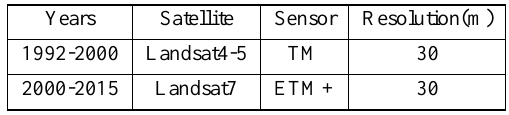
Table 1. Summary of remotely sensed data used in this